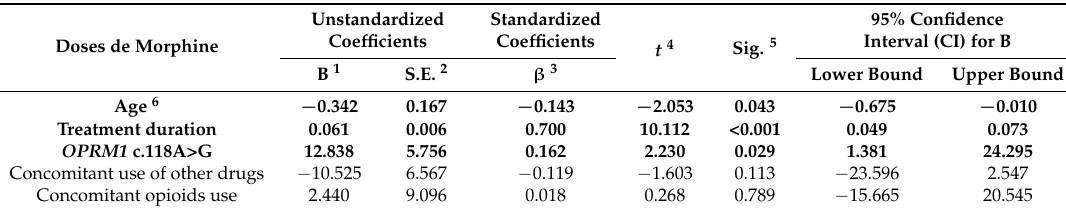
Table 4. Binary logistic regression for morphine dose at 24